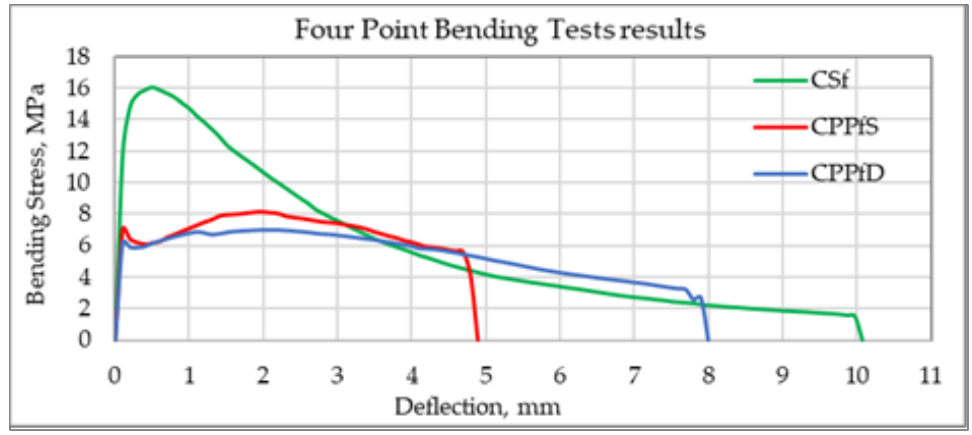
Figure 4. Average graphs: Stress — middle of a span Deflection, for all groups. The above plotted curves consist of the following phases: Group CSf: